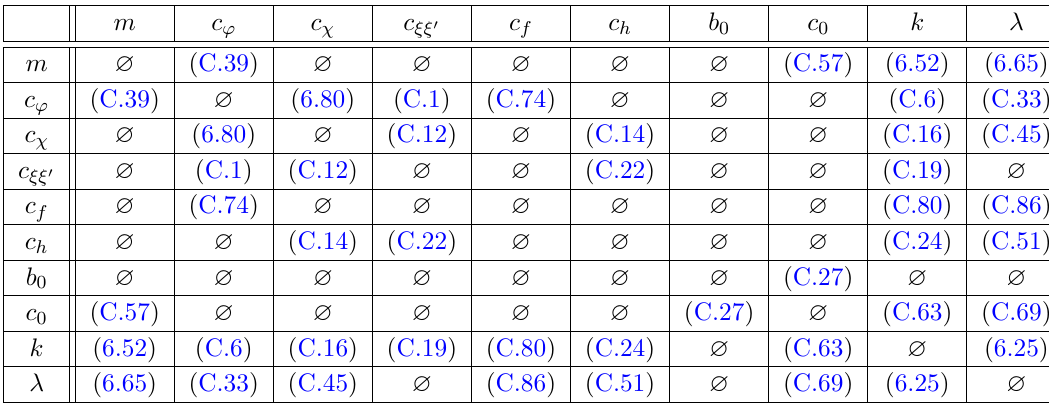
Table 4 . All possible two-flux dynamical systems. A ? indicates that the corresponding pair of fluxes does not relate to a possible subcase of